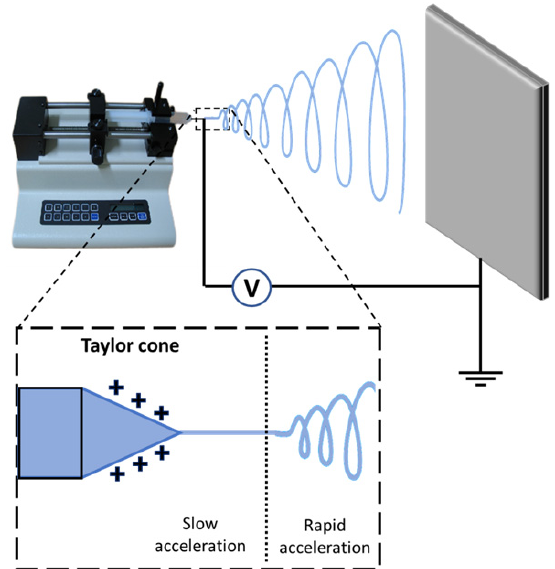
Figure 1. Scheme of the electrospinning setup and process.